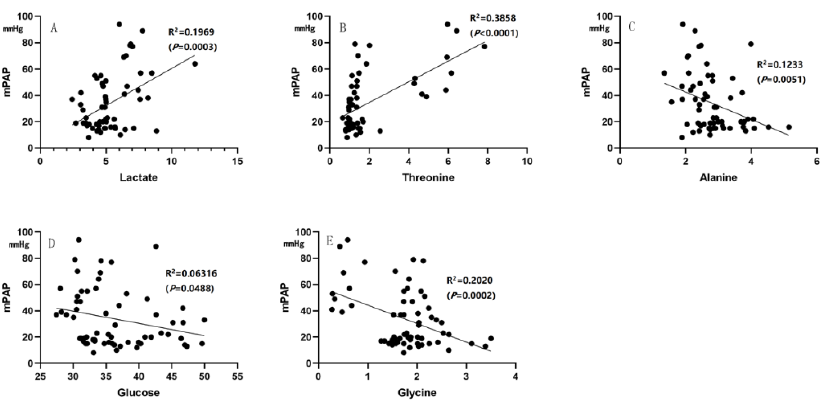
Figure 6. Correlation analysis. ( A , B ) Lactate and threonine were positively correlated with mPAP; ( C – E ) Alanine, glucose and glycine were negatively correlated with mPAP.